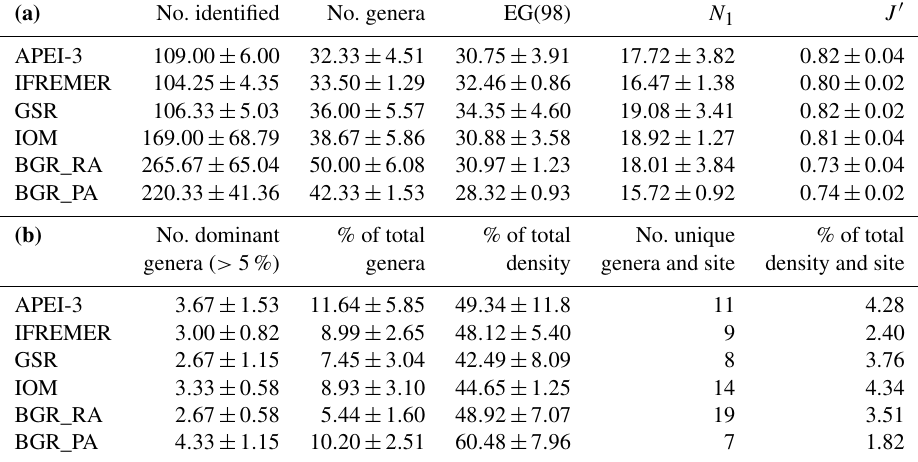
Table 5. (a) Nematode genus diversity (averaged over samples per site ± standard deviation) in the different CCZ areas. EG(98) is expected number of genera in a sample of 98 individuals, N 1 is Hill’s index and J (cid:48) is Pielou’s evenness. (b) Number of most abundant genera (averaged over samples per site ± standard deviation) occurring with > 5% in at least one replicate, and the fraction these represent in terms of nematode diversity (% of total genera) and density (% of total density). Additionally, the total number of unique genera per site (i.e. summed for all replicates) is given together with their combined contribution to total nematode density for each